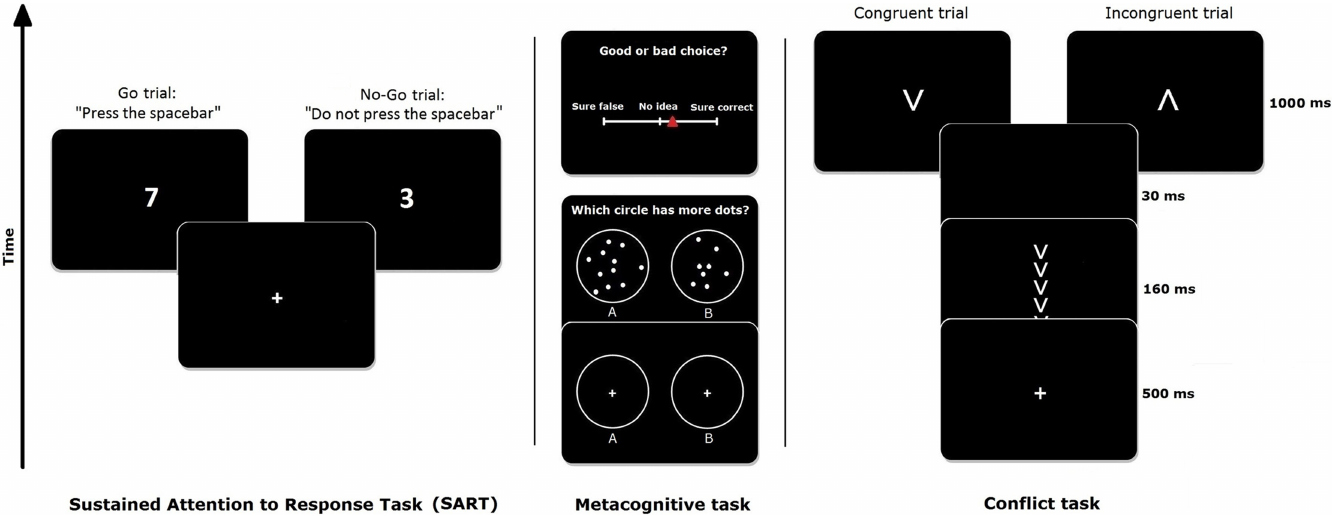
Fig 2. Left : The experimental paradigm of the SART. On each trial, a random digit (1–9) appeared on the screen, and subjects had to press the spacebar in response to all digits except 3. When the digit 3 appeared, they had to withhold their response (i.e., the No-Go trials). Middle : The metacognition task, adapted from Fleming et al. (2014). Two circles were presented with fixation crosses, followed by dot clouds (below). Participants had to choose the circle containing more dots. Subsequently, a rating of confidence was collected on a continuous bar with a red cursor (above). Right : The paradigm of the conflict task. Subjects were presented with a short prime stimulus consisting of a string of five arrows, pointing either in the same (congruent) or in the opposite (incongruent) direction as the subsequent target arrow. They were asked to respond to the direction of the target arrow.